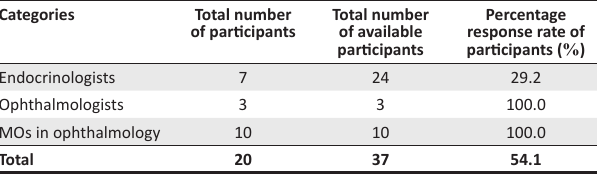
TABLE 1: Categories and number of